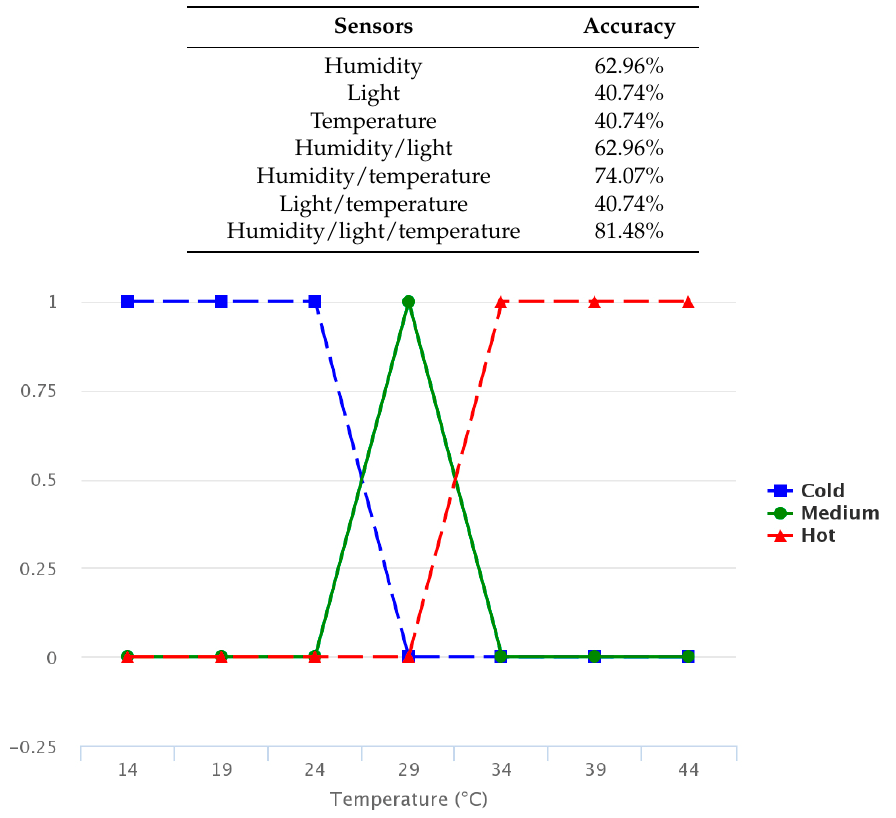
Table 3. Accuracy percentage (calculated with Bayes) depending on the irrigation levels, according to the variables indicated in Table 2.